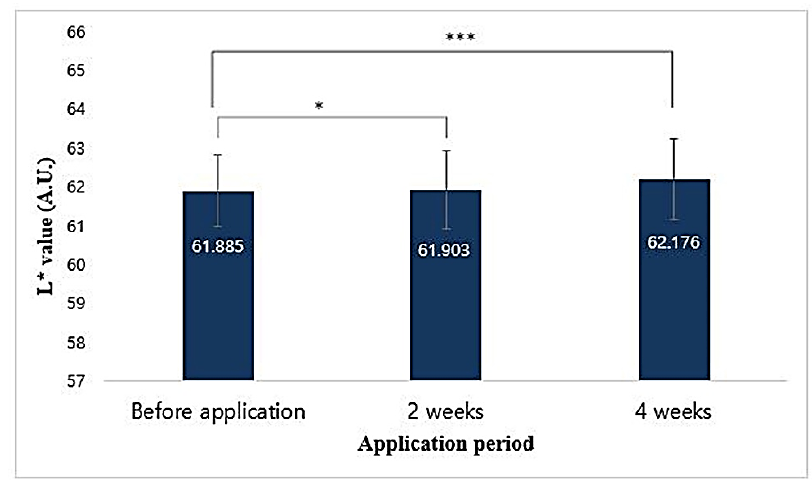
Figure 15. Correlation between application period of formulated cosmetics product and chromameter L* values. Data are given as mean ± SEM and statistical significance is shown by ANOVA (* p < 0.05; *** p <